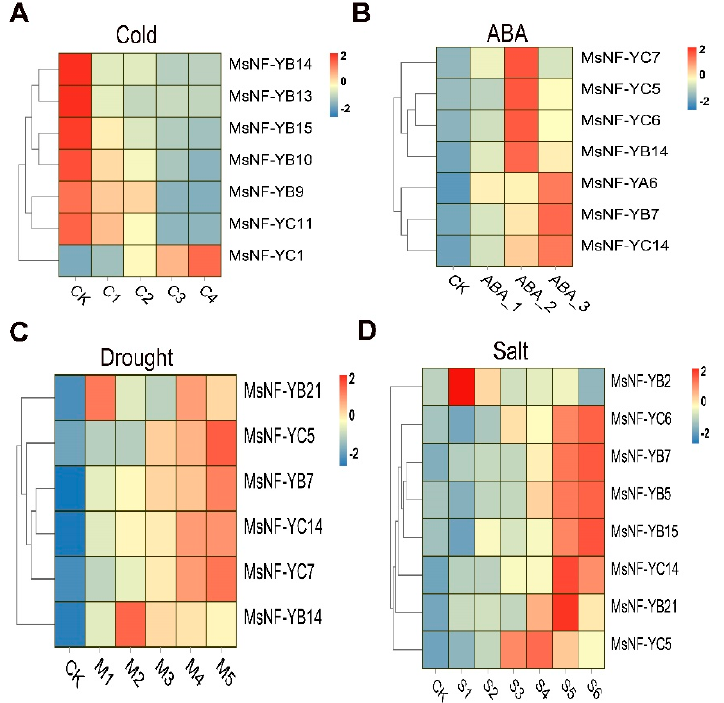
Figure 8. Candidate MsNF-Y genes responsible for different abiotic stresses. ( A ) MsNF-Y genes in- volved in the cold stress response. ( B ) MsNF-Y genes involved in the ABA treatment response. ( C ) MsNF-Y genes involved in the drought response. ( D ) MsNF-Y genes involved in the salt stress re- sponse.